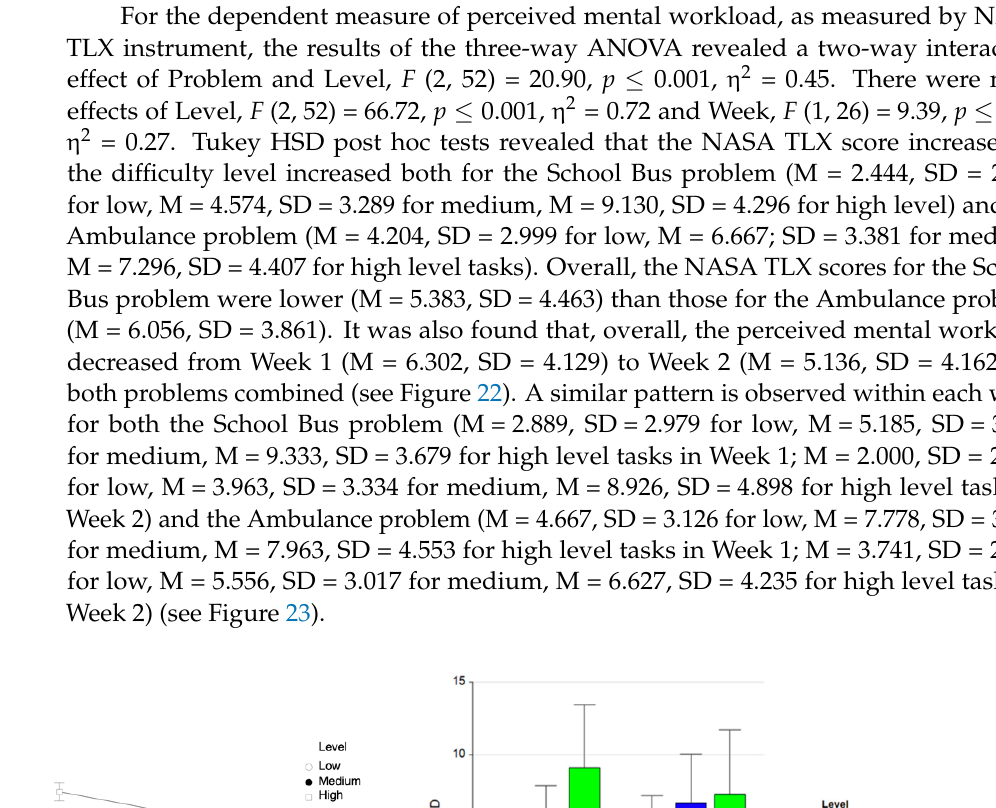
Figure 21. Bar charts represent the average standardized z-scores for oxygenation for right anterior prefrontal cortex (Z-RANTPFC-OXY) and standard deviation (SD) for low cognitive load, medium cognitive load, and high cognitive load tasks for School Bus (left) and Ambulance (right) problem scenarios for Week 1 and Week 2.